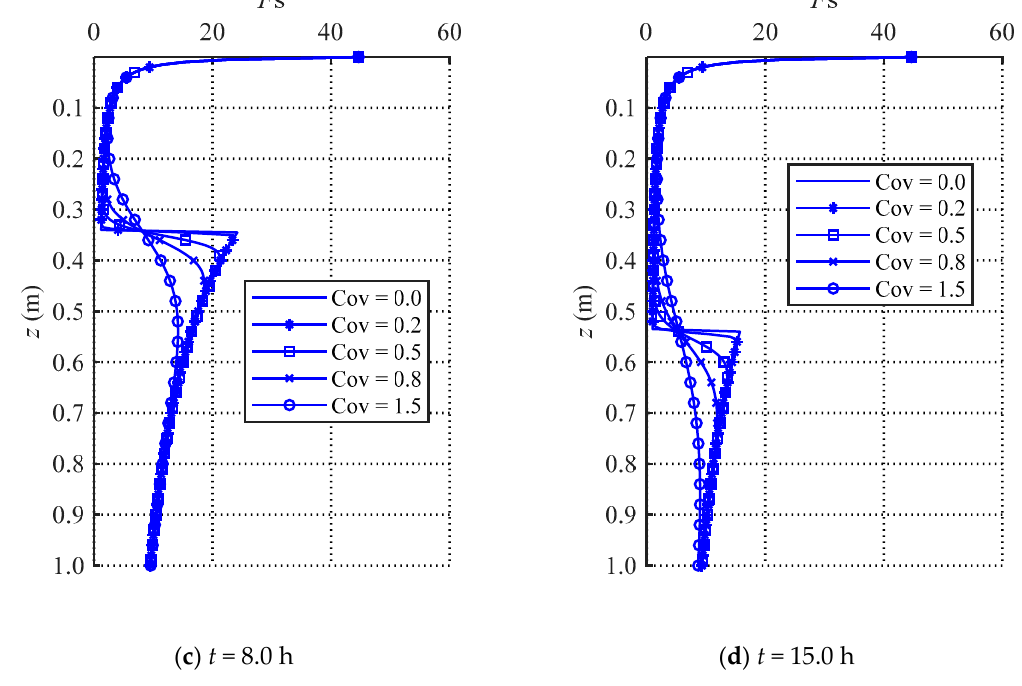
Figure 14. Evolution of safety factor profiles over time.